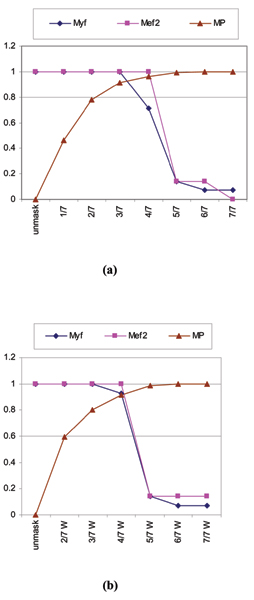
The effect of (a) SMM and (b) WBMM on the size of sequence space to be searched and on the percentage of true binding sites retained for the muscle genes. Masking percentage (MP) is defined in Methods. 't/7' represents SMM and indicates that a base is retained if the base is in the non-repeat region and conserved in at least t of the 7 species (Methods). 't/7 W' indicates the corresponding WBMM.